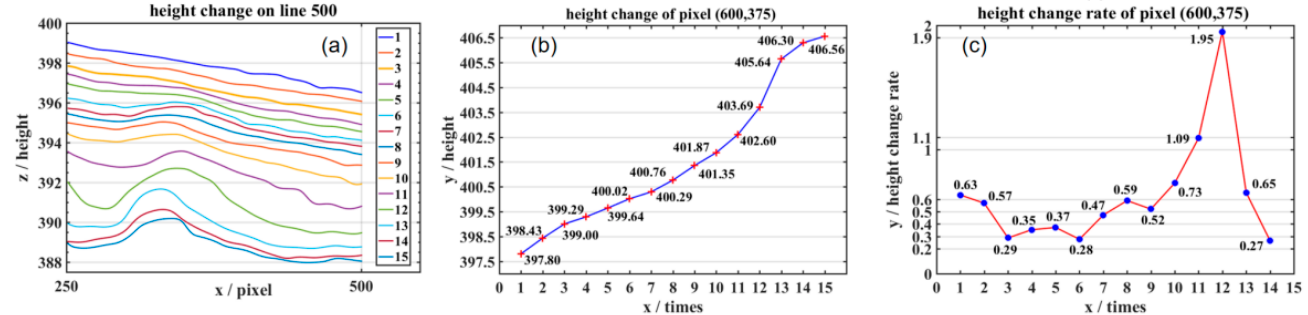
Figure 14. Comparison of height changes of ( a ) the same line of layers 1–15, ( b ) pixel position